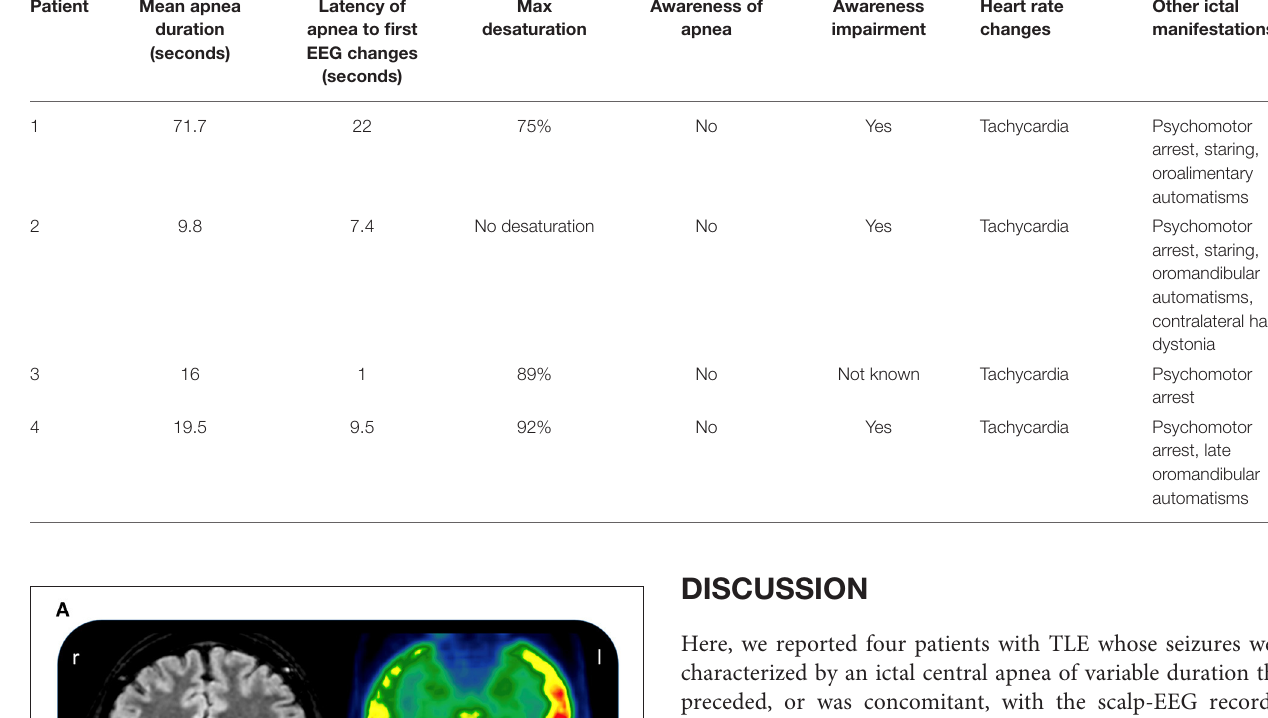
TABLE 1 | Summary of apnea related findings in the described patients. Patient